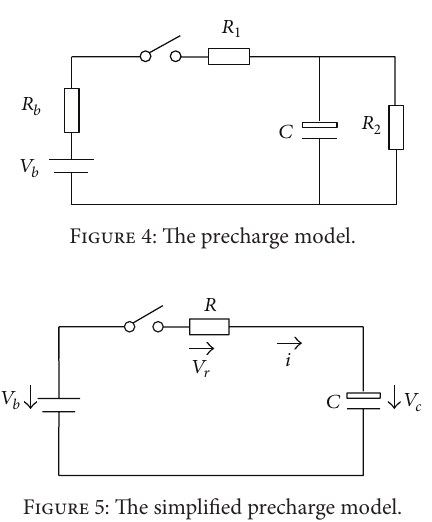
Figure 5: The simplified precharge